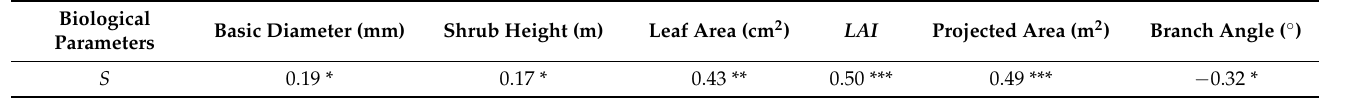
Table 5. Correlation coefficients between the absolute water storage capacity ( S ) and basic diameter, shrub height, leaf area, LAI , projected area, and branch angle. n =